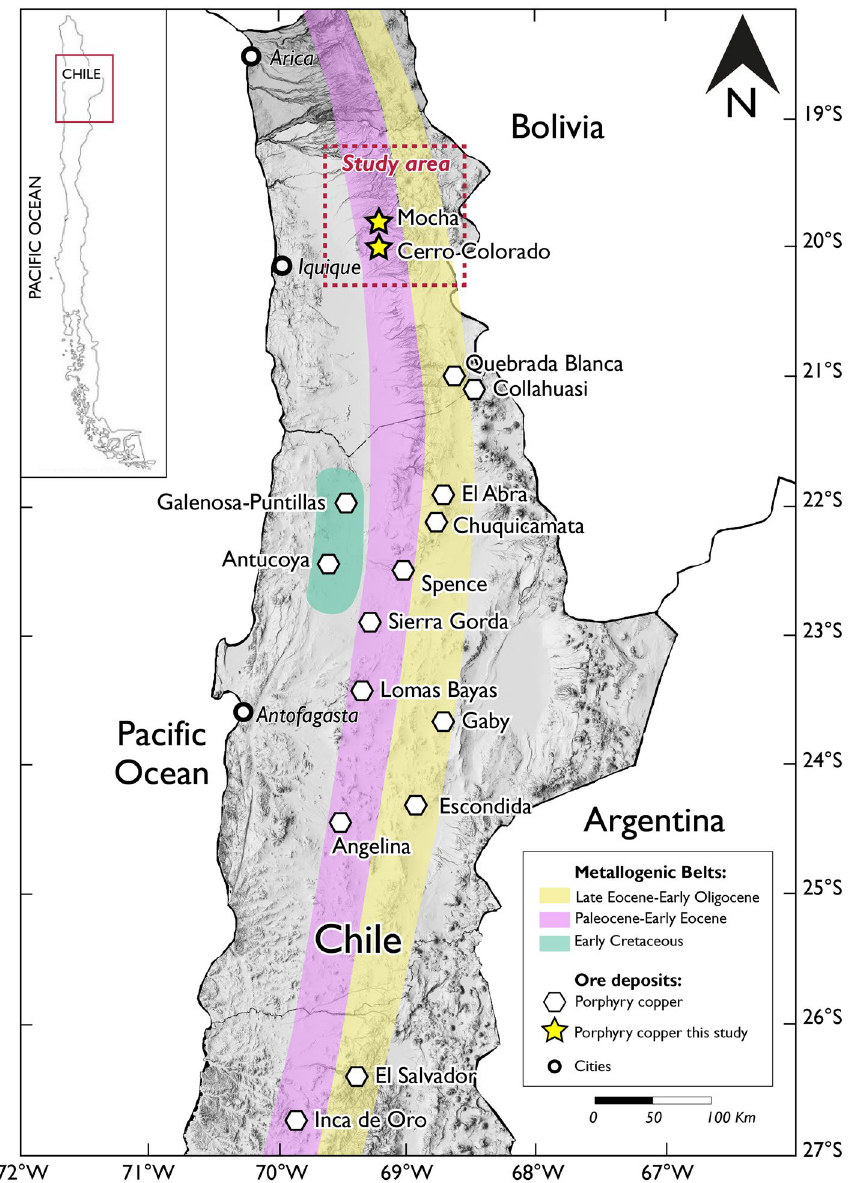
Figure 1. Location of porphyry copper deposits in major metallogenic belts of northern Chile (~ 19.2°S and 20.3°S). The rectangle with red dotted line corresponds to the study area, which includes the Cerro